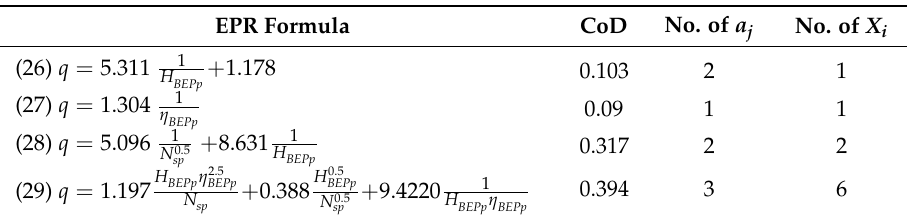
Table 14. Models returned by EPR-MOGA for q.